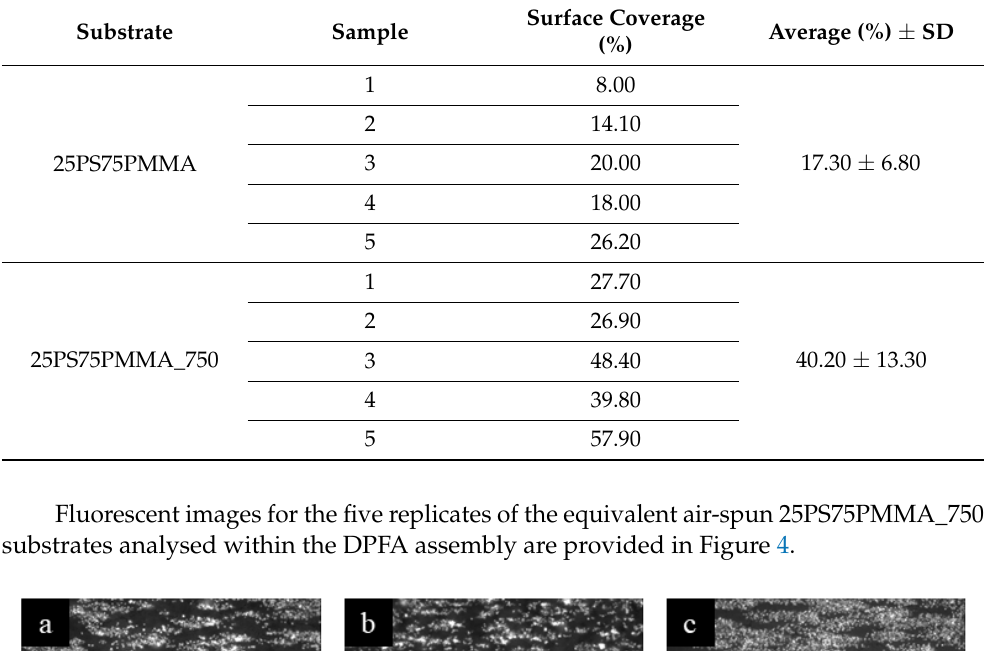
Table 4. Average % surface coverage values (n = 5) ± standard deviation (SD) taken from frame 120/120 of fluorescently-labelled platelets on 25PS75PMMA and 25PS75PMMA_750 substrates after DPFA testing.